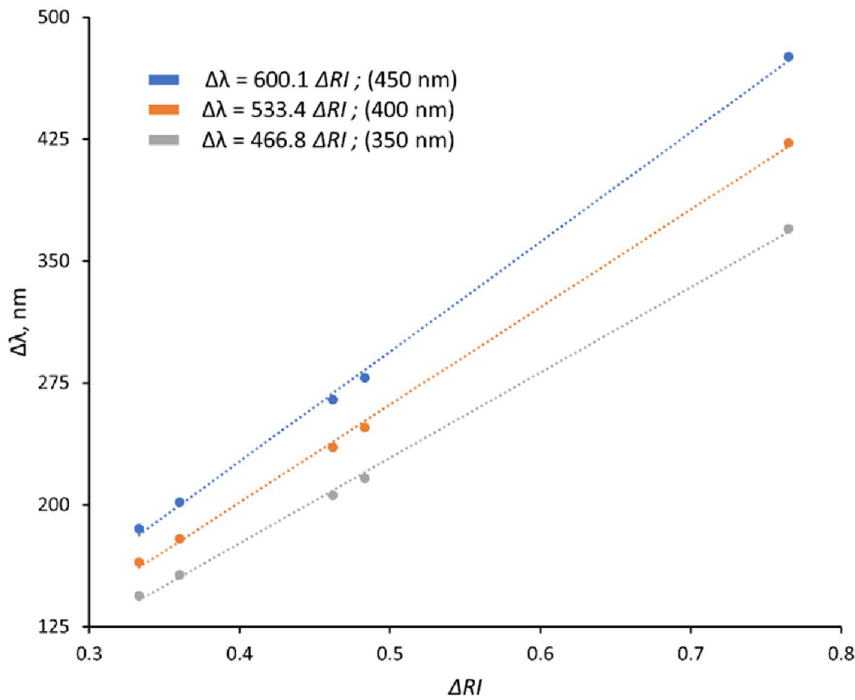
Figure 5. The calculated sensitivity factor (Eq. 2) for the plasmonic devices used for SAM detection corresponding to three different pattern periodicities: 350, 400 and 450